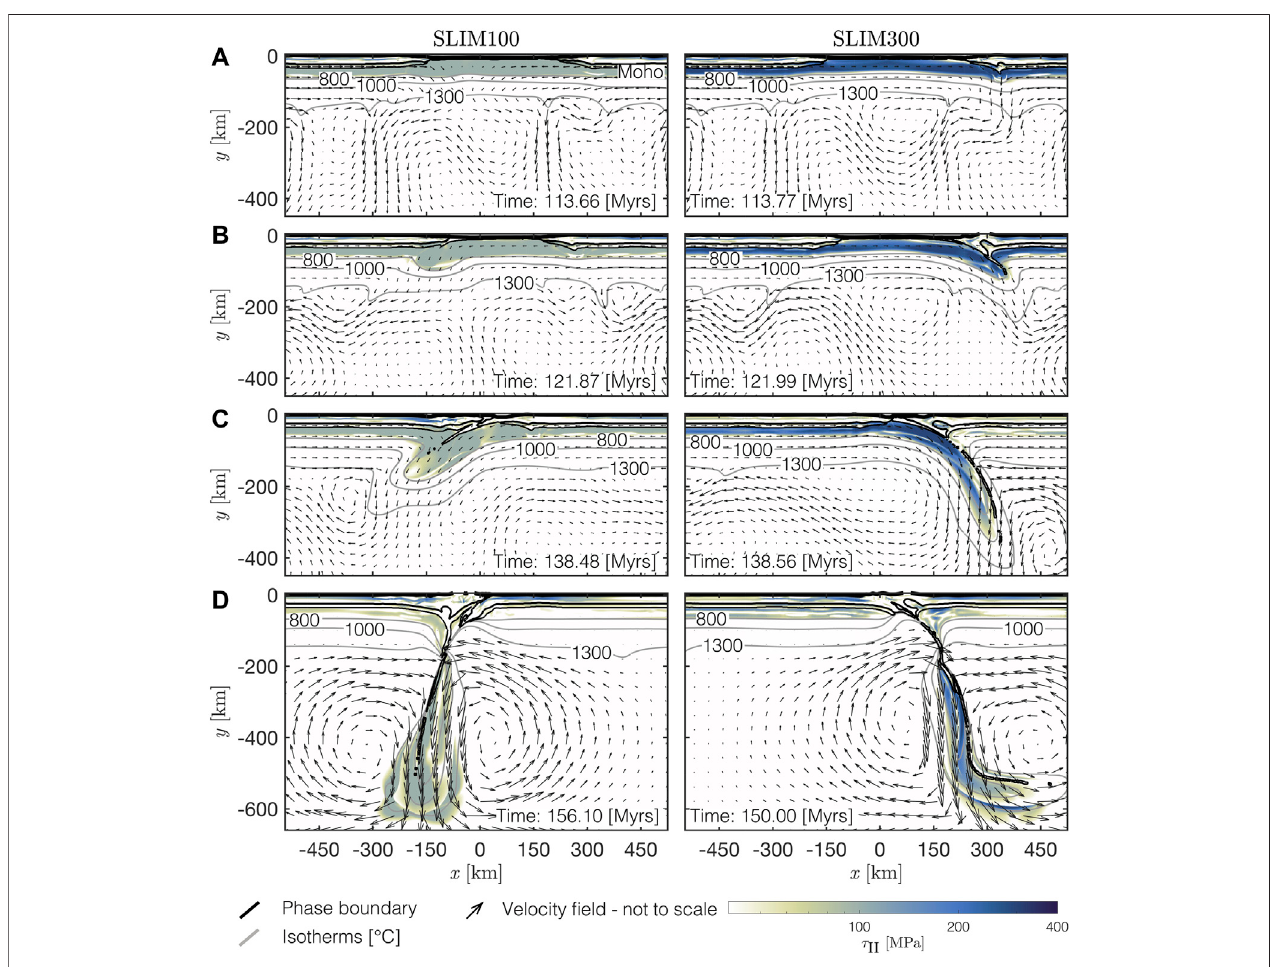
FIGURE6| Comparingtheevolutionofthesubductionzone inSLIM100 (leftcolumn)and SLIM300(rightcolumn).Blacksolidlinesarephaseboundariesandgrey solid lines are several isotherms. White to blue colors are the second invariant of the deviatoric stress tensor and glyphs indicate the velocity fi eld calculated by the numerical algorithm at various stages: (A) Subduction initiation, (B) embryonic subduction zone, (C) mature subduction zone and (D) slab detachment. Note that subduction is initiated below the opposite margin in SLIM100.